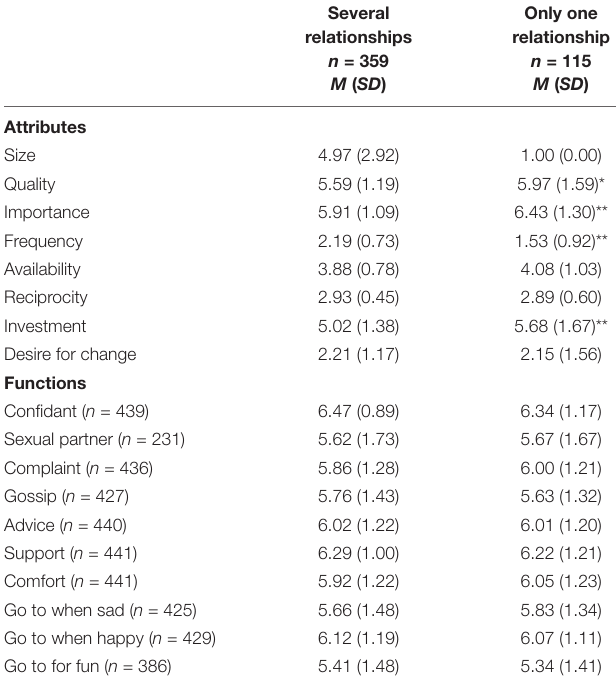
TABLE 6 | Means and standard deviations of the FAR for one relationship vs. many relationships.